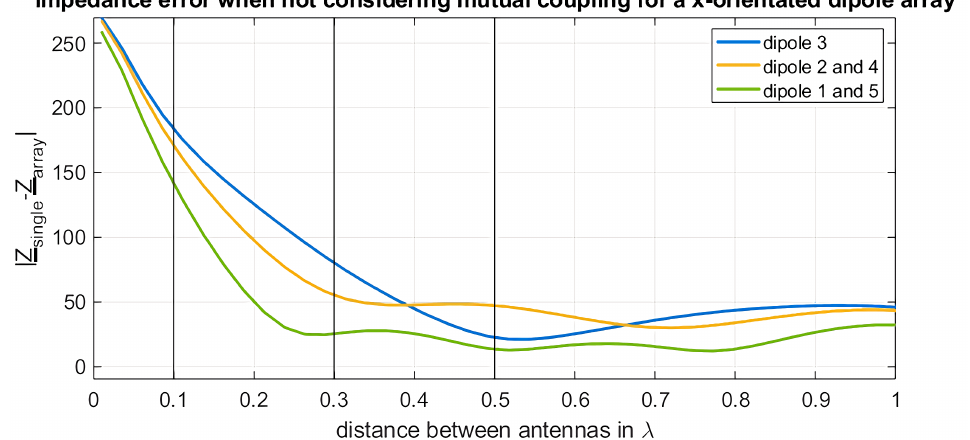
Figure 15. The difference of the impedance between the two computation methods for every dipole as a function of the distance between the array elements in